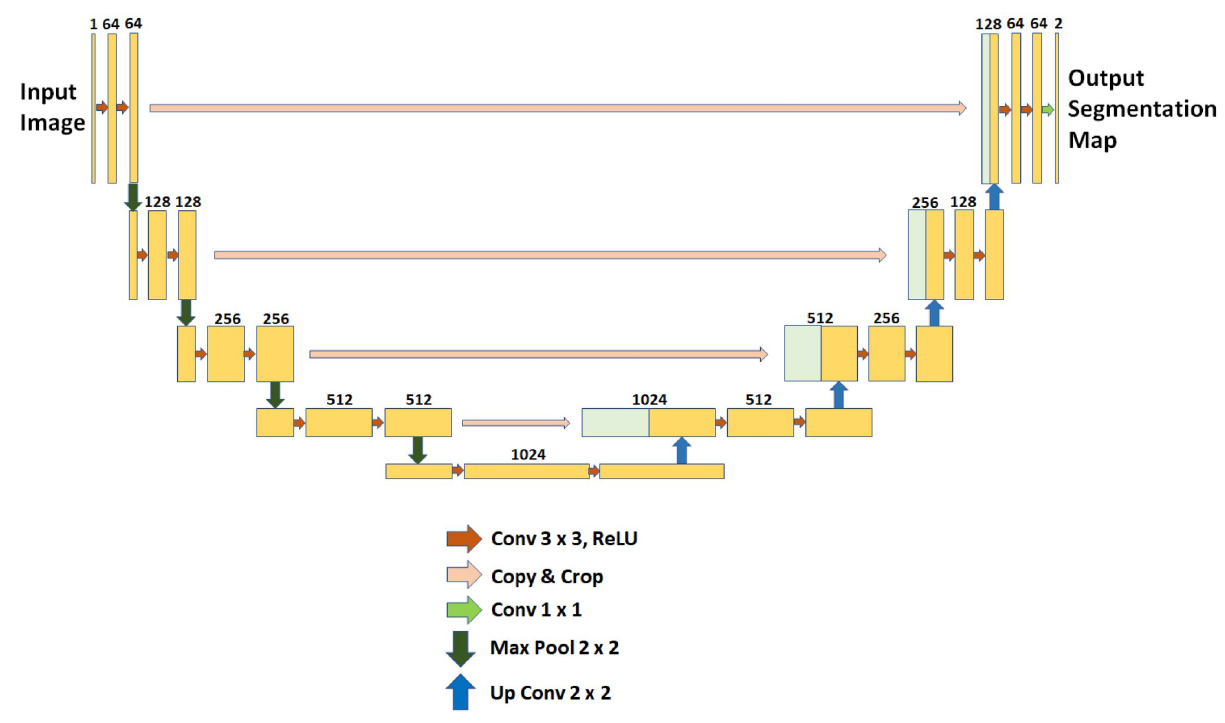
Fig 5. Basic U-Net